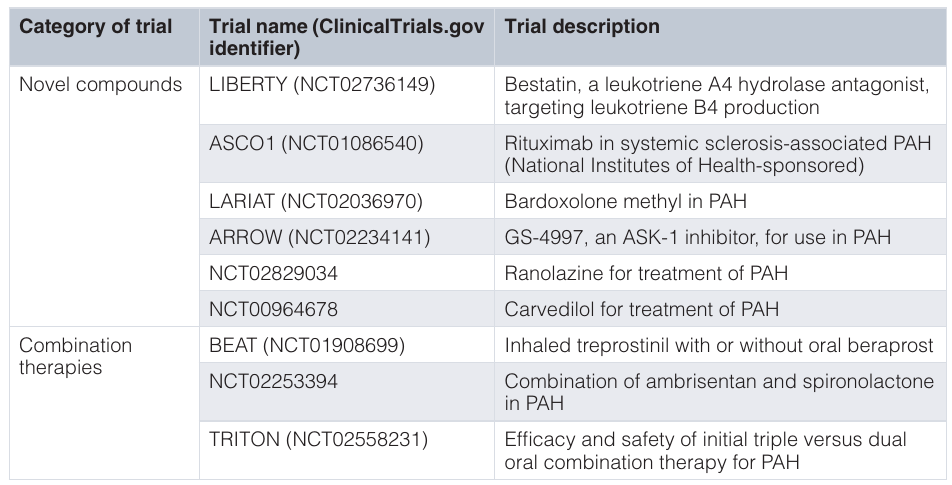
Table 2. Current clinical trials in pulmonary